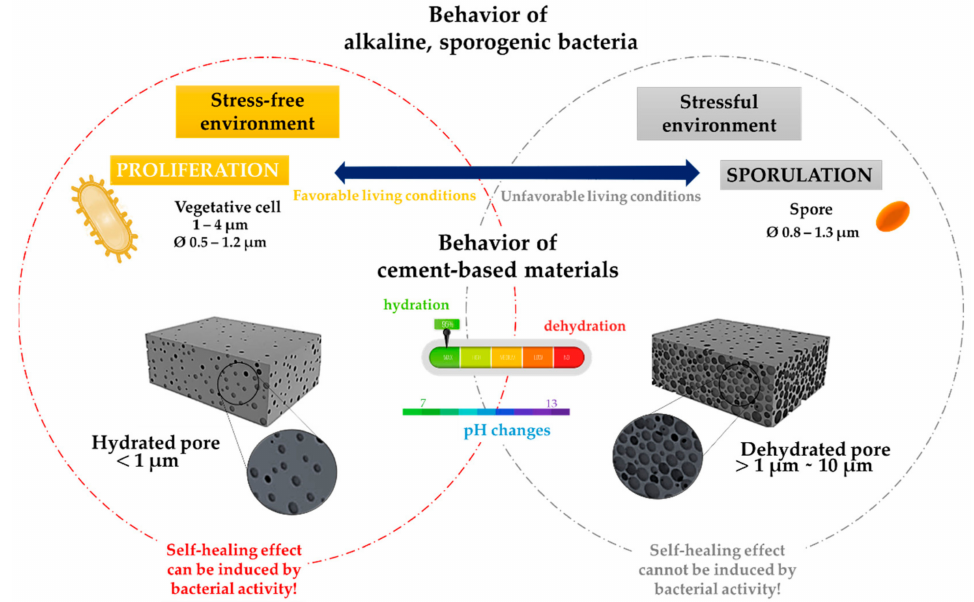
Figure 3. The bacterial life cycle depends on the cement-based